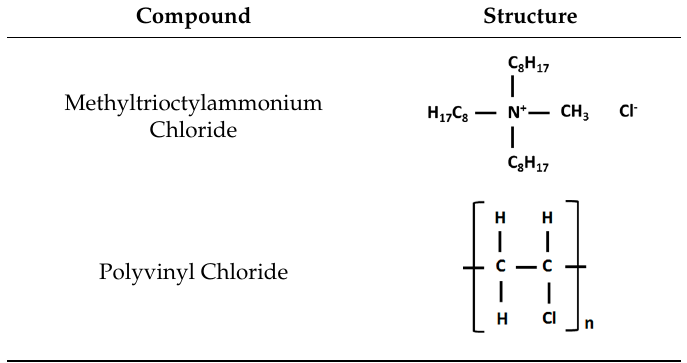
Table 1. Structure of both the ionic liquid and the polymer used to prepare the membranes. Compound